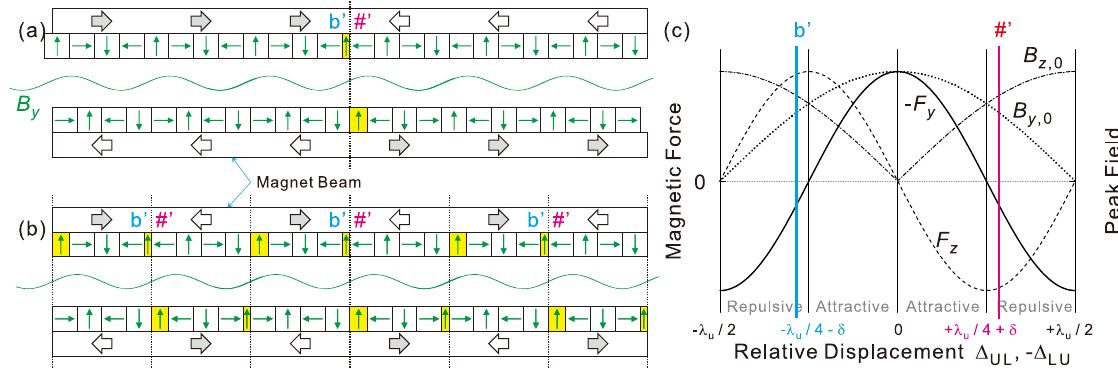
FIG. 3. Method for a fine adjustment of the magnetic force in the PCU (a) D ¼ 2 and (b) D ¼ N